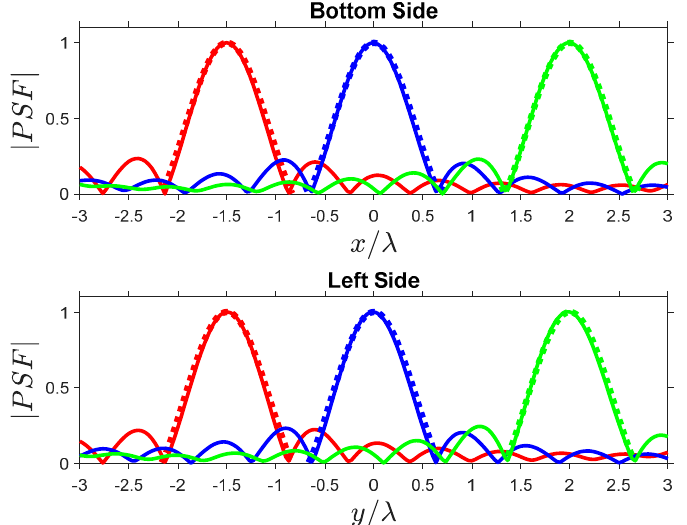
Figure 13. Comparison of the actual PSF (dotted lines) and approximated (cid:103) PSF (solid lines) for the bottom and left sides in the angle mode for x 0 = − 1.5 λ (red lines), x 0 = 0 λ (blue lines), and x 0 = 2 λ (green lines).